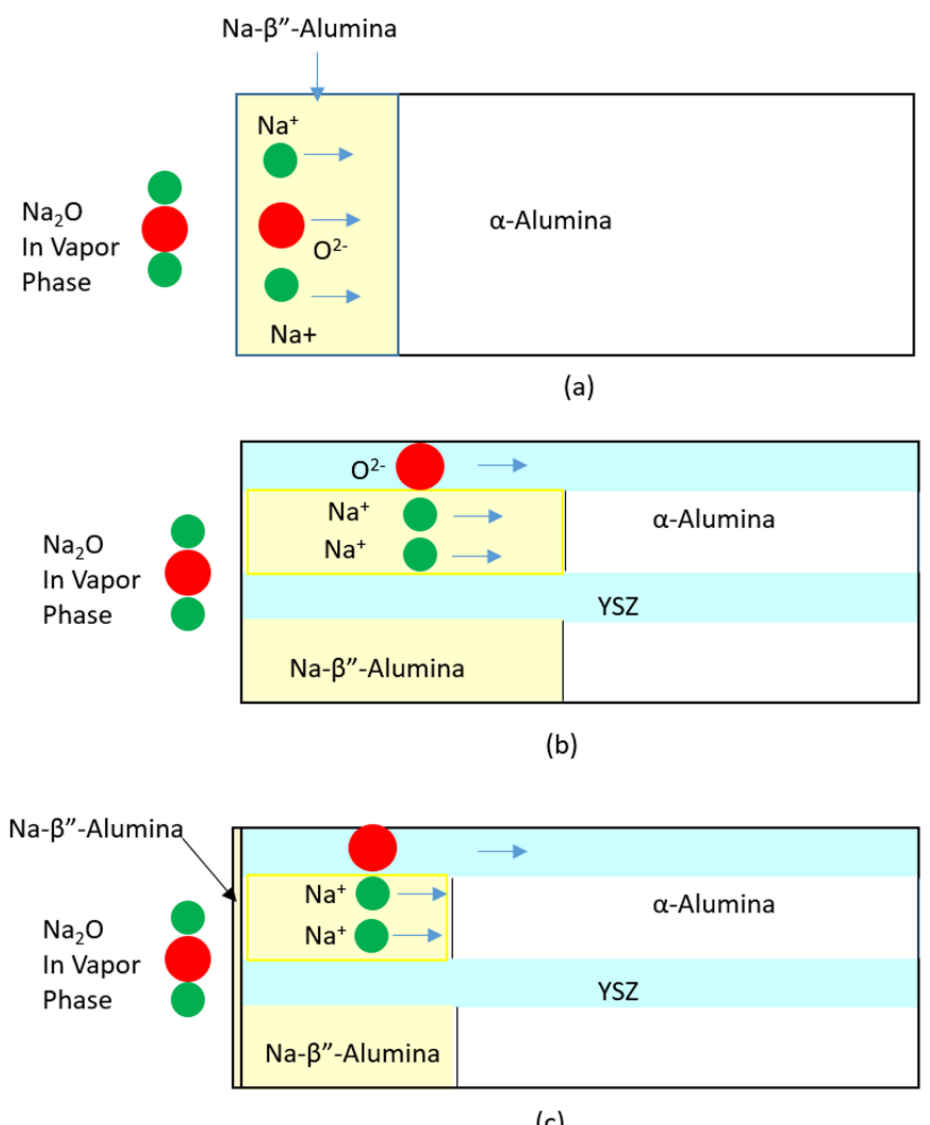
Figure A1. Schematics showing vapor phase conversion in ( a ) single phase α -alumina, ( b ) α -alumina + YSZ composite, and ( c ) α -alumina-coated α -alumina + YSZ composite. The schematics do not show grain structure in this one-dimensional model. The widths of YSZ, α -alumina, and Na- β ”-alumina are essentially equal to the respective volume fractions.